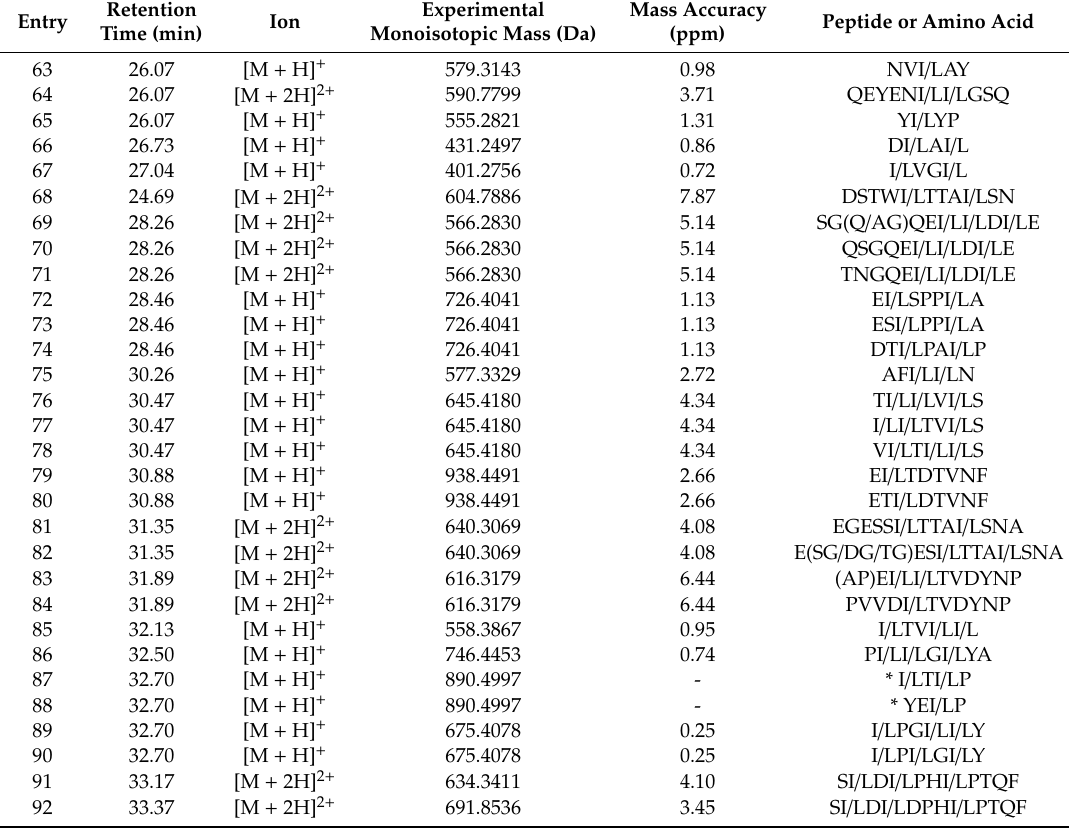
extract, at a lower concentration than the 1090 cell line. The e ff ect of the low MW peptide fractions H-PROT-1 (t2h, t4h, t6h and t24h) on fibroblast proliferation was lower compared to that of PROT-1 on both cell lines. Indeed, in the wells treated with H-PROT-1 (t24h), the cell viability reached 79% for the 1059-cell line and 78% for the 1090-cell line. These results showed that decreasing the MW of PROT-1 proteins led to a reduced e ff ect on cell proliferation for both cell